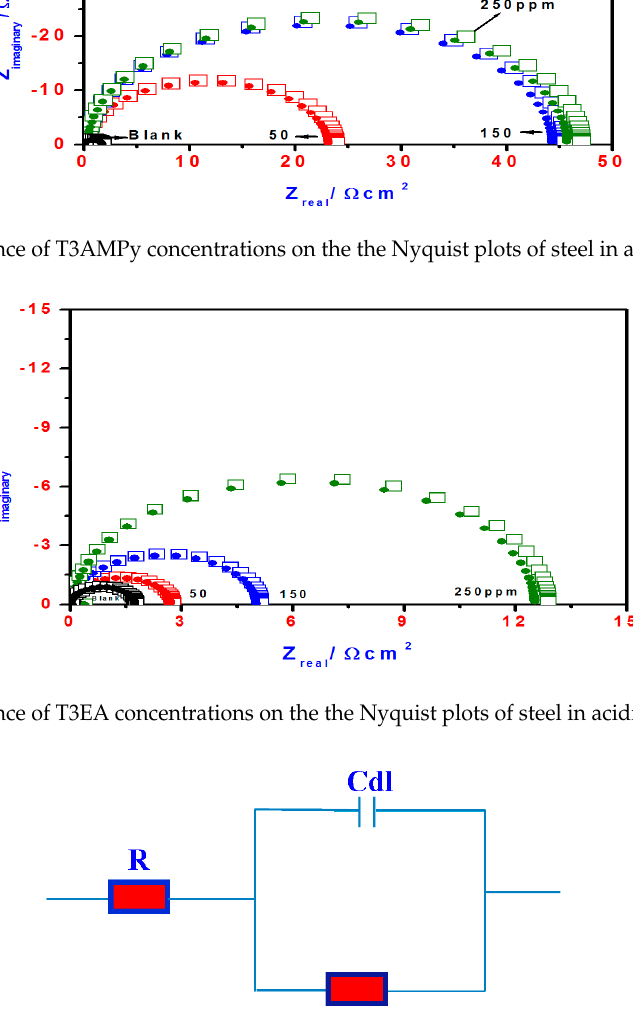
Figure 8. The equivalent used in fitting the EIS experiemtal data.